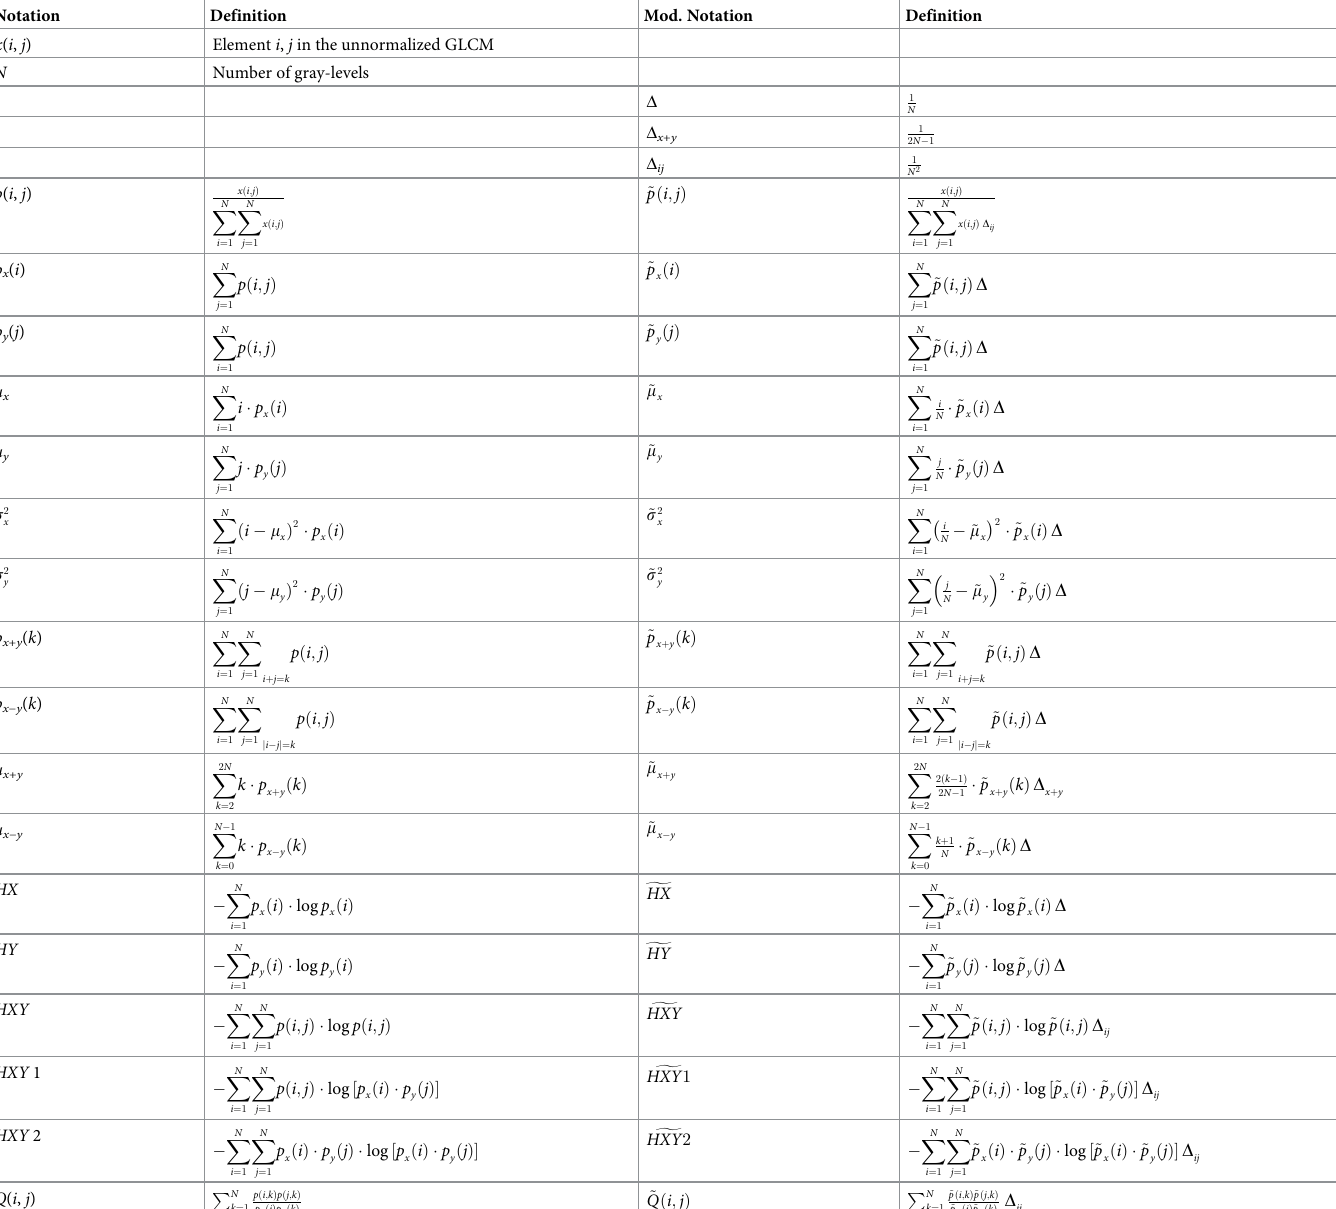
Table 1. Variables and notation used to compute the Haralick texture features. The two left-most columns show the original definitions, and the two right-most col- umns show the modifications needed to make the feature invariant to the number of